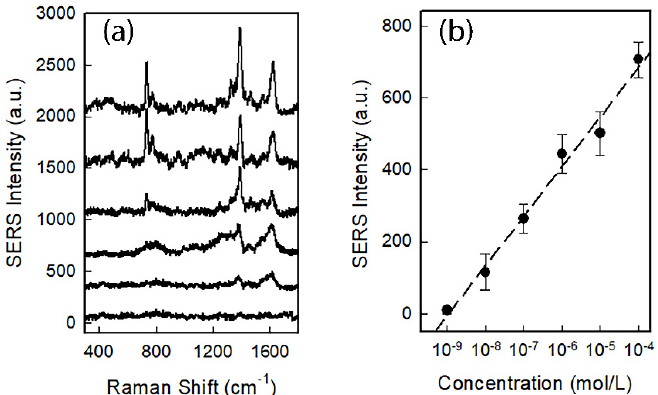
Figure 8. ( a ) SERS spectra of norfloxacin water solutions with concentration ranging from 10 − 9 (lower spectrum) to 10 − 4 M (upper spectrum) spotted on GNS@Ag300 SERS chips; ( b ) calibration curve obtained from mode at 1390 cm − 1 (r 2 = 0.987).